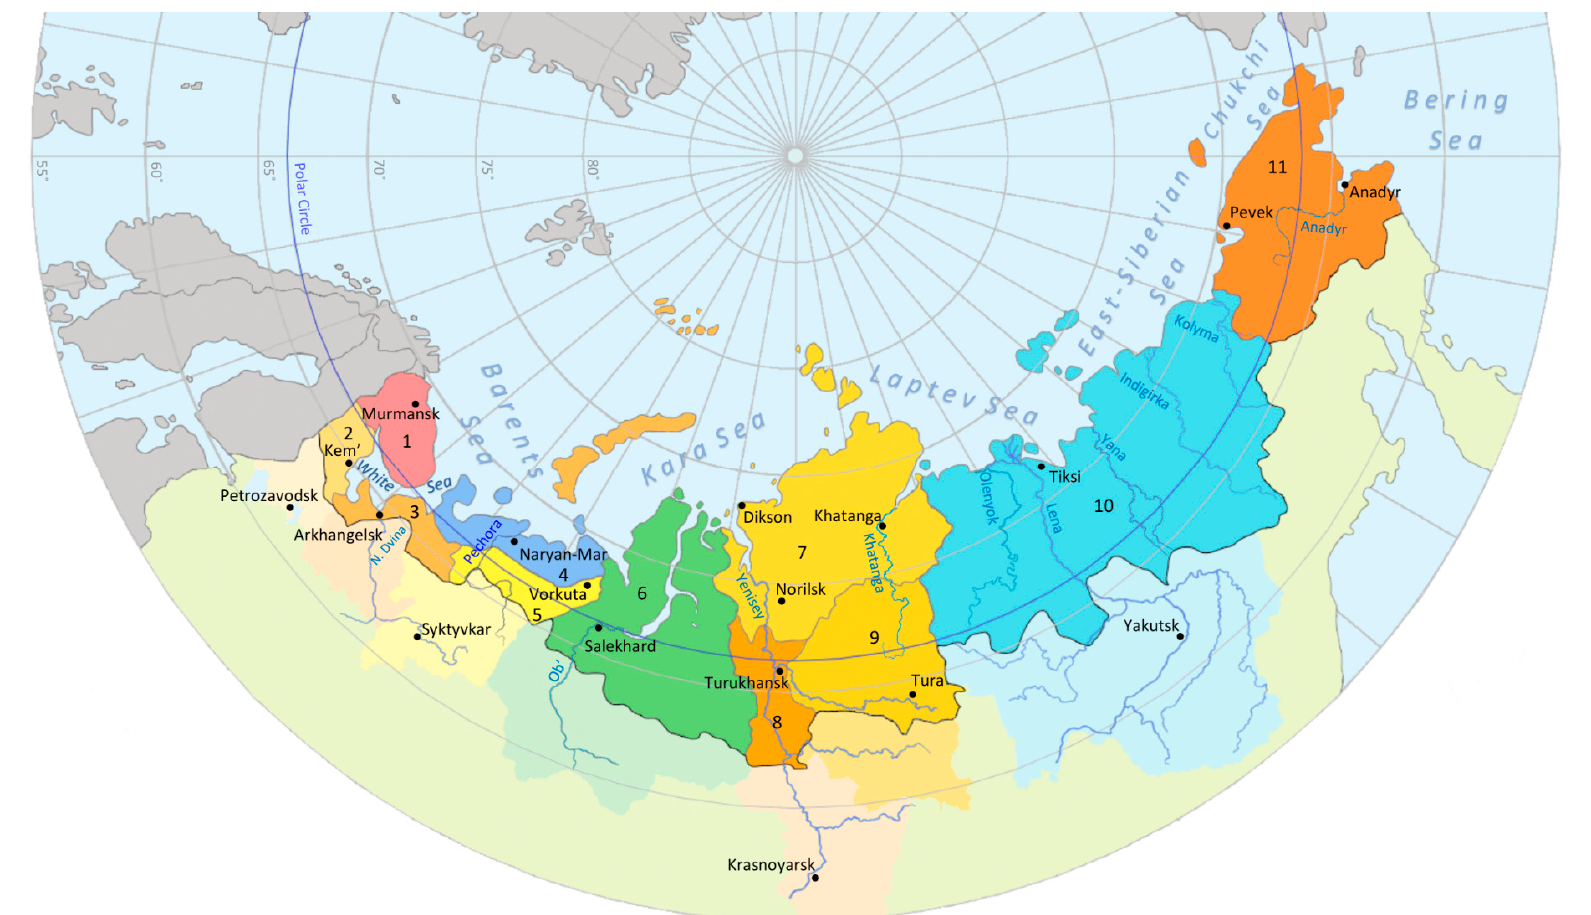
Figure 1. Map of the Russian Arctic territory (“Arctic Zone of the Russian Federation”): 1—Murmansk Oblast; 2—Karelia republic (northern districts); 3—Arkhangelsk Oblast (northern districts); 4—Nenets autonomous okrug; 5—Komi republic (northern districts); 6—Yamalo-Nenets autonomous okrug; 7—Taimyr Dolgano-Nenets District of the Krasnoyarsk kraj; 8—Turukhansky District of the Krasnoyarsk kraj; 9—Evenkiysky District of the Krasnoyarsk kraj (northern areas); 10—Yakutia (Sakha) republic (northern districts); 11—Chukotka autonomous okrug. ( The map was designed by Alexey V. Dozhdikov, research assistant from the Northwest Public Health Research Center, St-Petersburg, Russia).